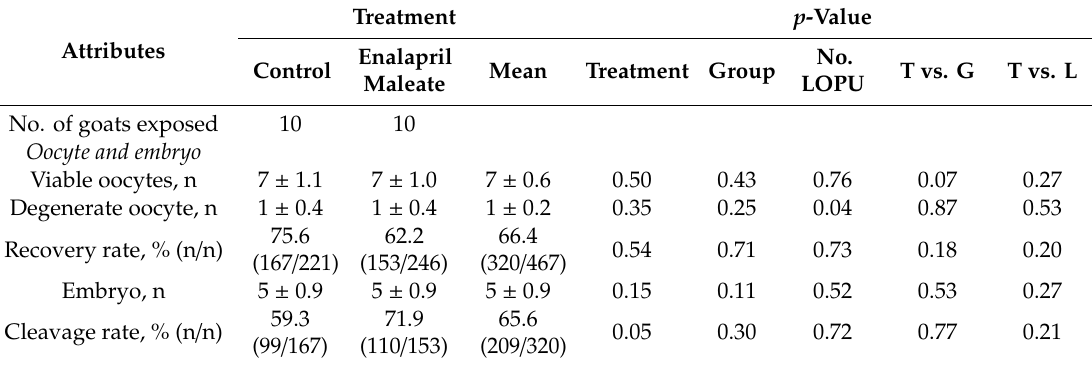
Table 2. Oocyte quality and in vitro embryo yield from Nulliparous and Multiparous hormonal stimulated goats treated with enalapril maleate. Values are expressed as mean ± standard error of the